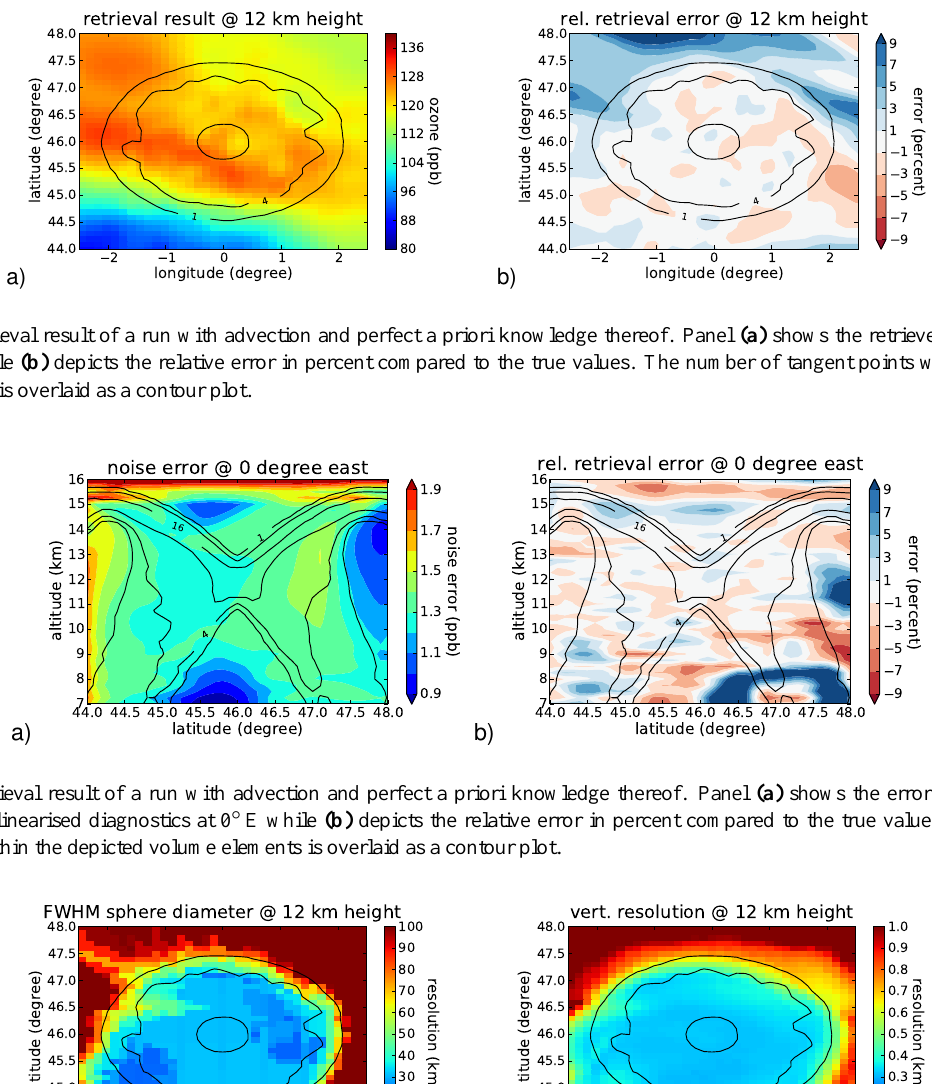
Fig. 12. The temporal change caused by advection. This figure depicts the scene at the end of the measurement period. In addition, horizontal wind speed at 12 km altitude has been added using barbs, whereby half a line indicates 5 m / s and a full line 10 m / s horizontal wind speed.